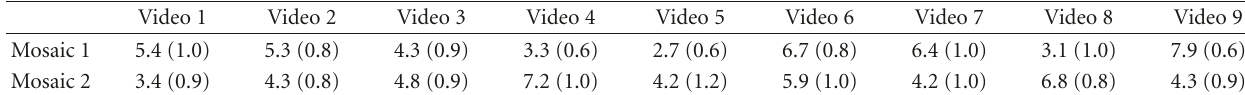
Table 1: Ranking positions and confidence interval of dyadic interactions.